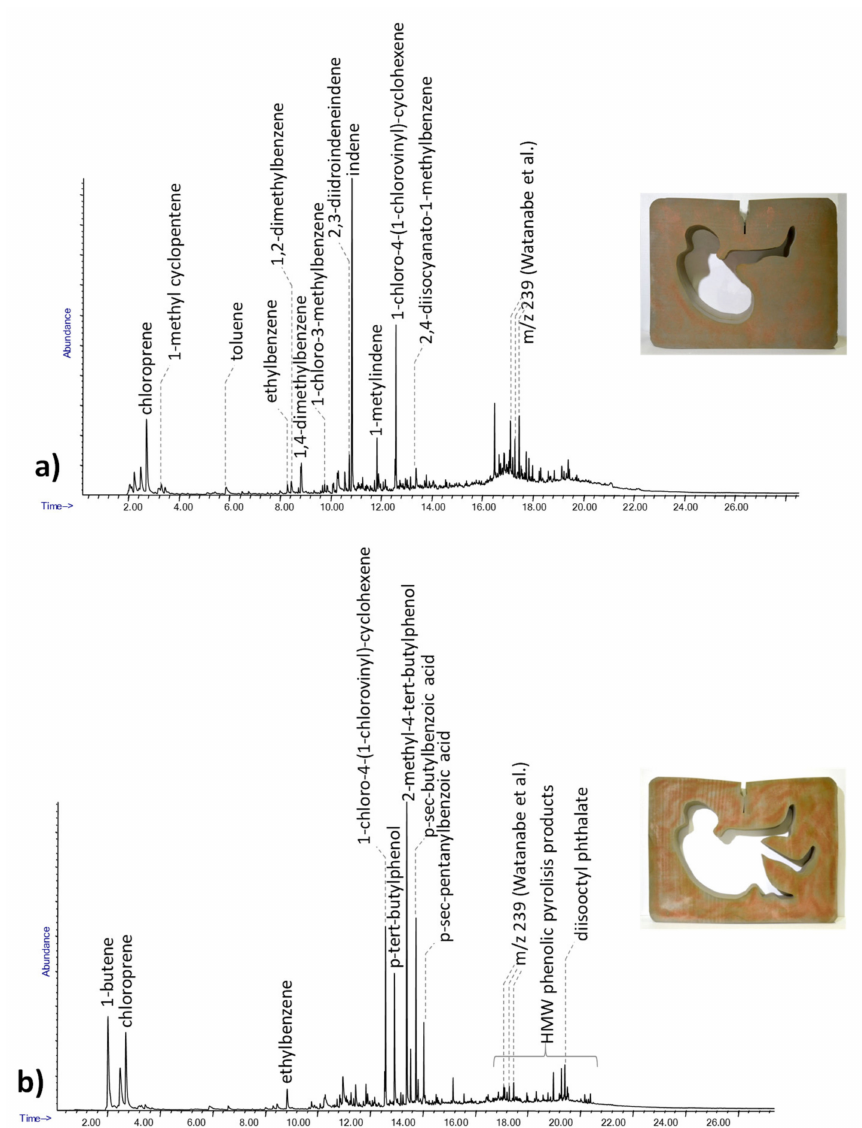
Figure 4. The Py-GC / MS chromatograms obtained for the white ( a ) and red ( b ) adhesive samples from Contenitore Umano. The pyrolysis products described in